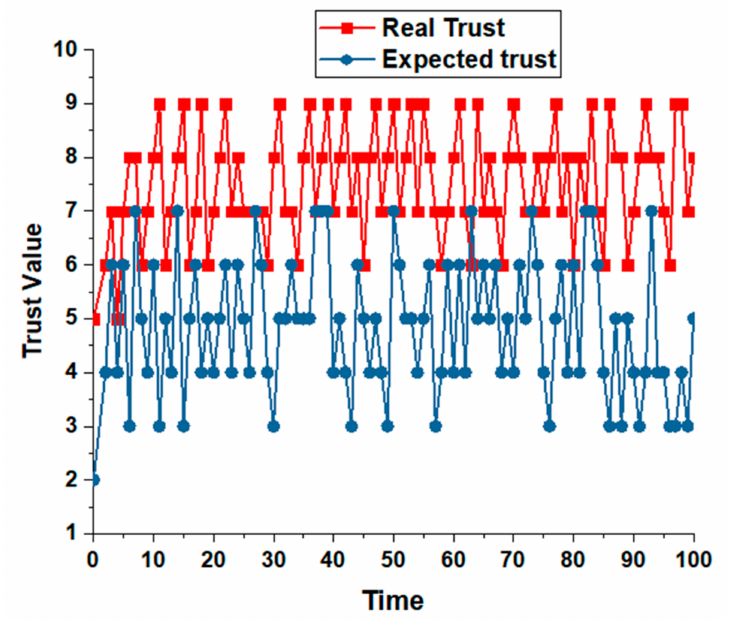
Figure 15. Trust value and trust computations based on